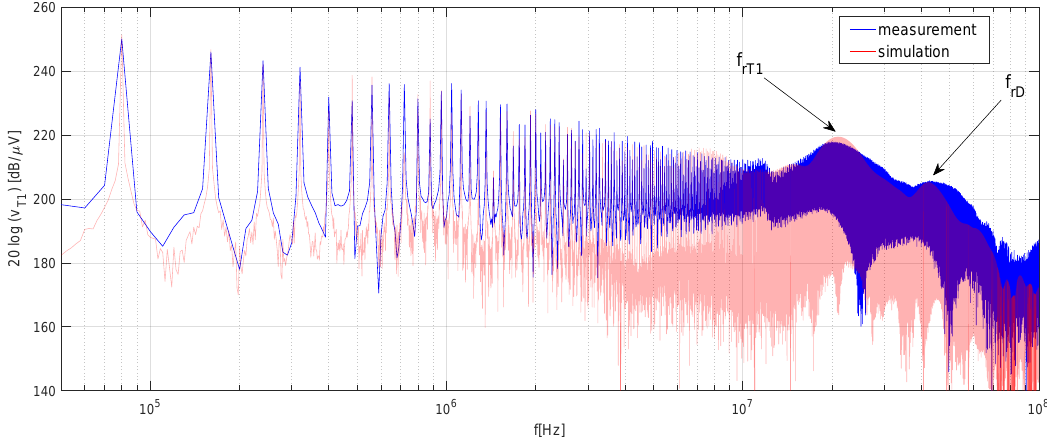
Figure 11. The comparison of V T 1 spectra measured and simulated.